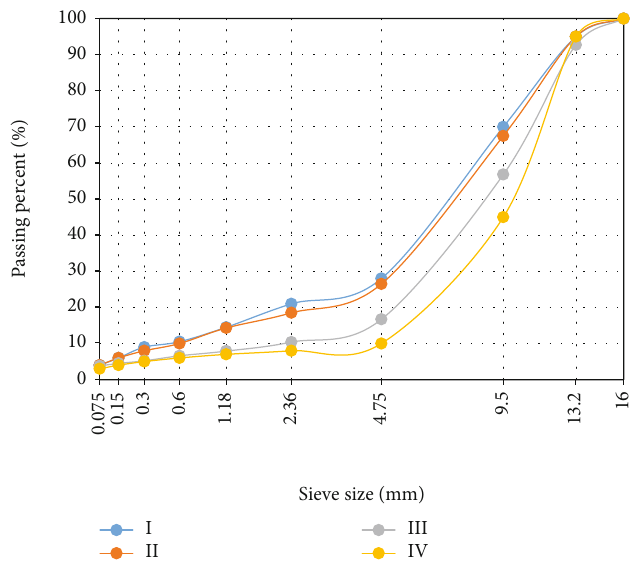
Figure 1: Aggregate